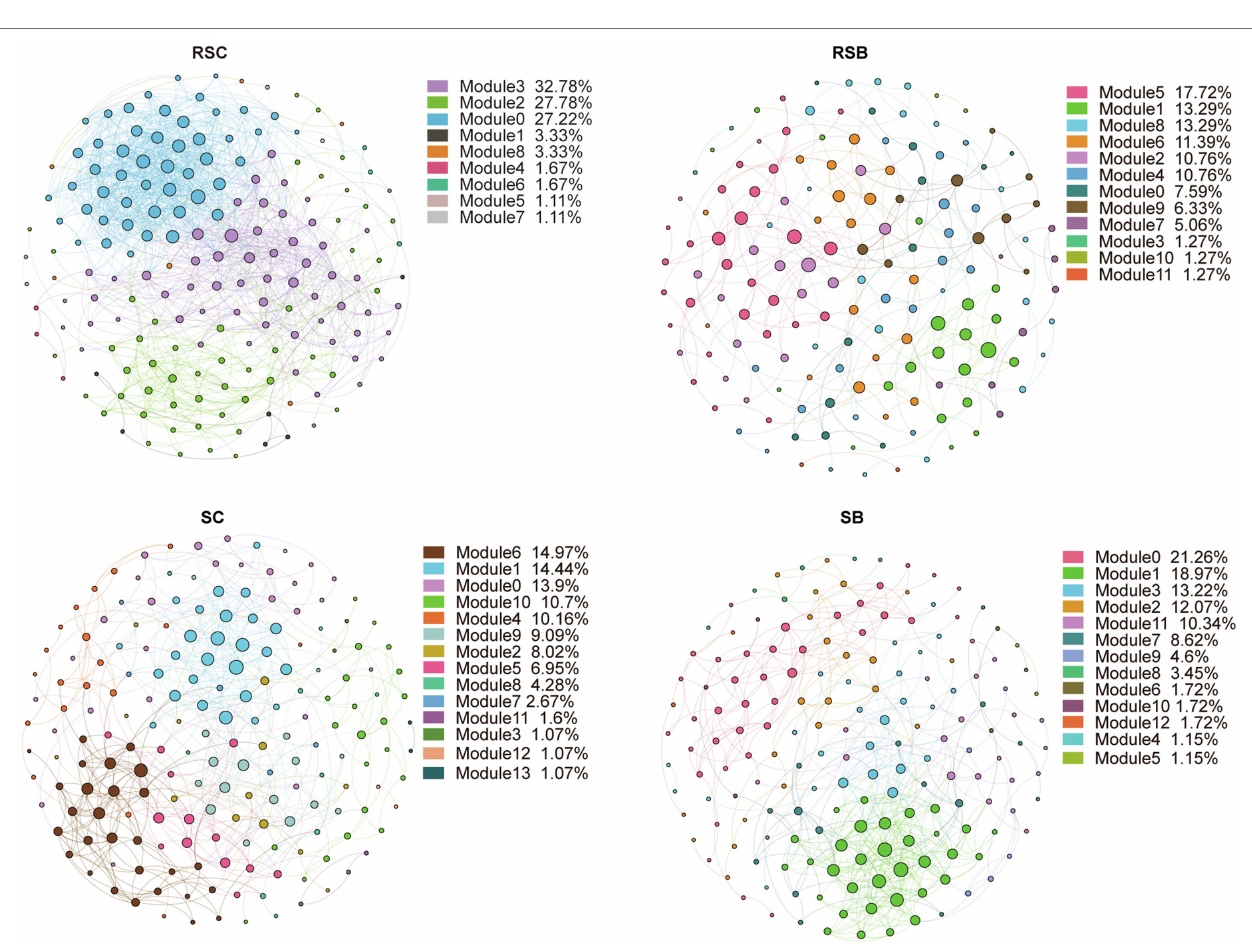
FIGURE 5 | Species-species and species-environment association network. A connection stands for a strong (Spearman’s | r | > 0.6) and significant (value of p < 0.01)